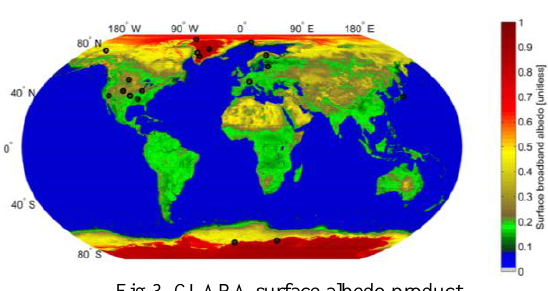
Fig.3. CLARA surface albedo product Average of the monthly-mean CLARA SAL product in